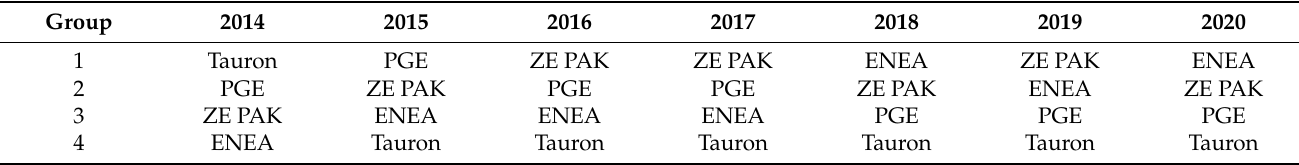
Table 21. Share of achieved EBITDA in the capital expenditures incurred.